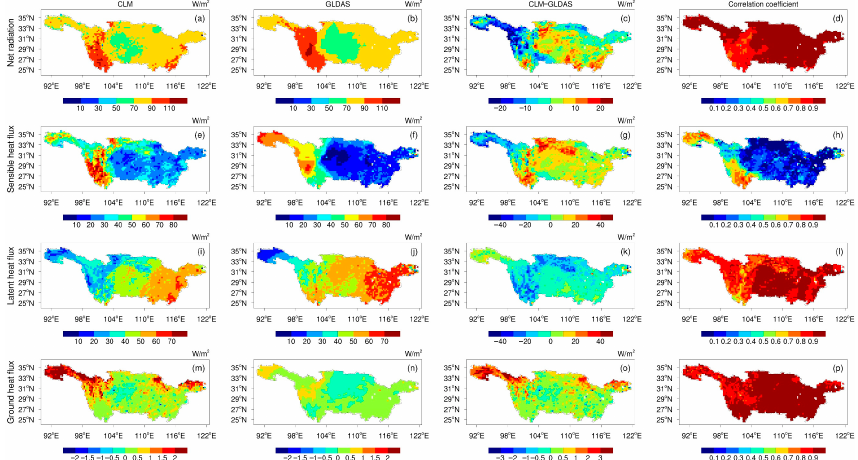
Figure 6. Spatial distribution of mean energy flux elements of CLM and GLDAS-Noah. ( a , e , i , m ) is net radiation, sensible heat flux, latent heat flux and ground heat flux for CLM. ( b , f , j , n ) is net radiation, sensible heat flux, latent heat flux and ground heat flux for GLDAS. ( c , g , k , o ) is the differences of net radiation, sensible heat flux, latent heat flux and ground heat flux between CLM and GLDAS. ( d , h , l , p ) is the correlation coefficient of net radiation, sensible heat flux, latent heat flux and ground heat flux between CLM and GLDAS.